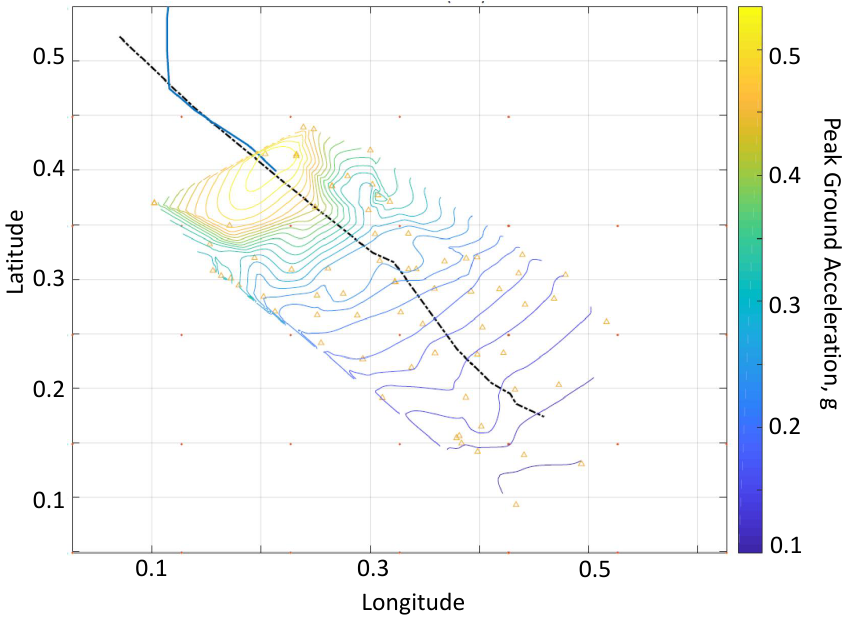
Figure 2. Spectral acceleration for period T = 0 s for the Portland Hills Fault (M = 6.8) north end rupture